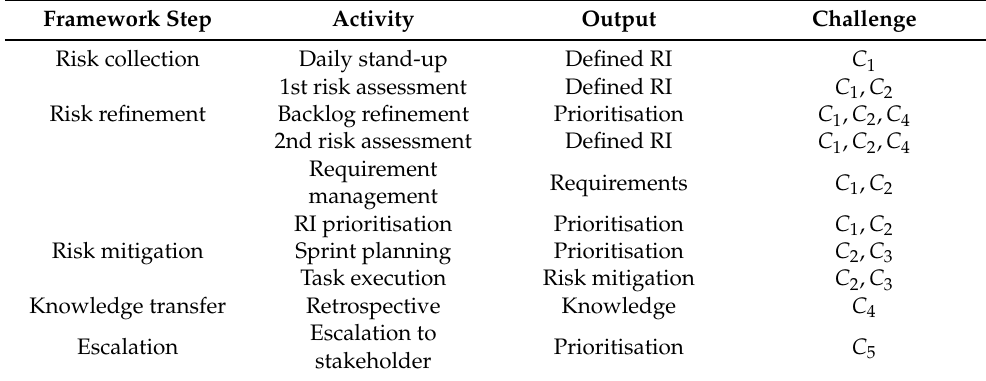
Table 2. Defined steps of the proposed framework including output for each activity, and correspond- ing challenges that are